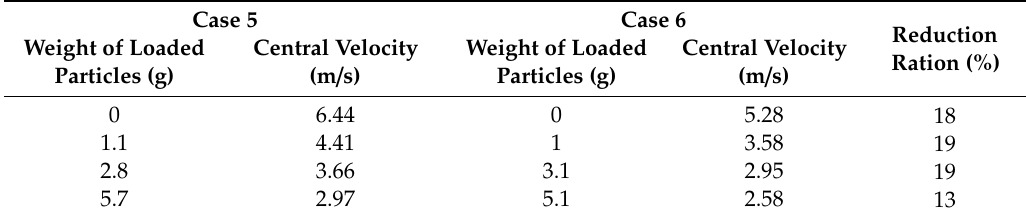
Table 8. Central velocity comparison of case 5 (conventional cone) and case 6 (NURBS cone).